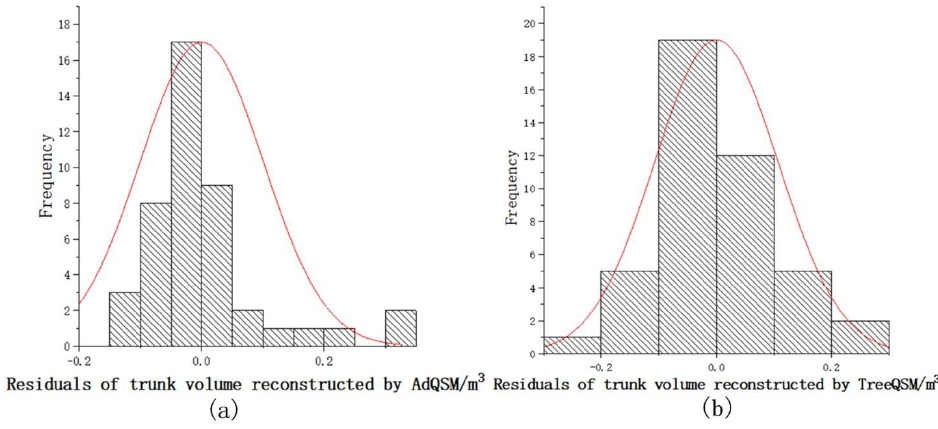
Figure 17. Trunk volume residual frequency distribution of ( a ) AdQSM and ( b ) TreeQSM. Table 2 provides accuracies of AdQSM and TreeQSM reconstructed trunk volumes. The Bias and rBias reconstructed by AdQSM were 0.07066 m 3 and 18.73%, respectively. The trunk volume deviation of 84.1% of all sample trees was less than 0.12369 m 3 . The tree trunk volume Bias and rBias based on TreeQSM were − 0.05071 m 3 and − 13.44% respectively. The trunk volume deviation of 65.9% of all sample trees was less than 0.13267 m 3 . Table 2. Comparison of the accuracy of tree trunk volume estimation between AdQSM and TreeQSM and the allometric equation.